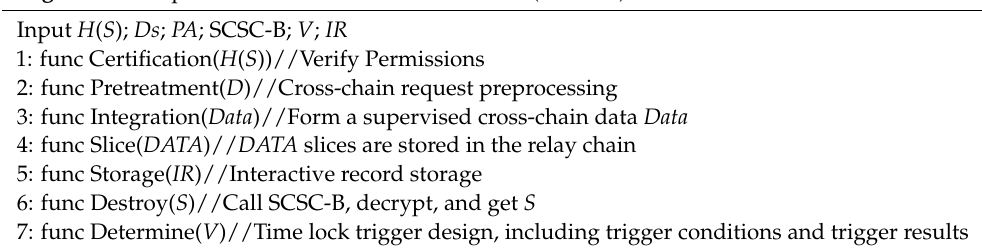
Algorithm 3 Supervise cross-chain smart contract